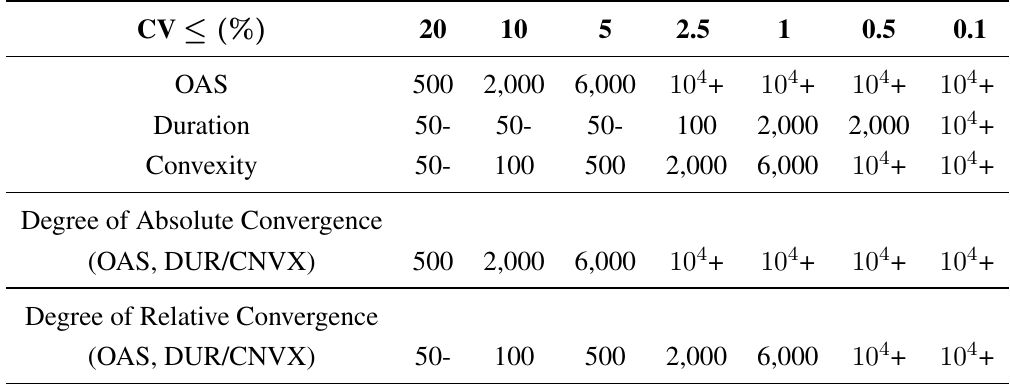
Table 1. Convergence results for FNCL using